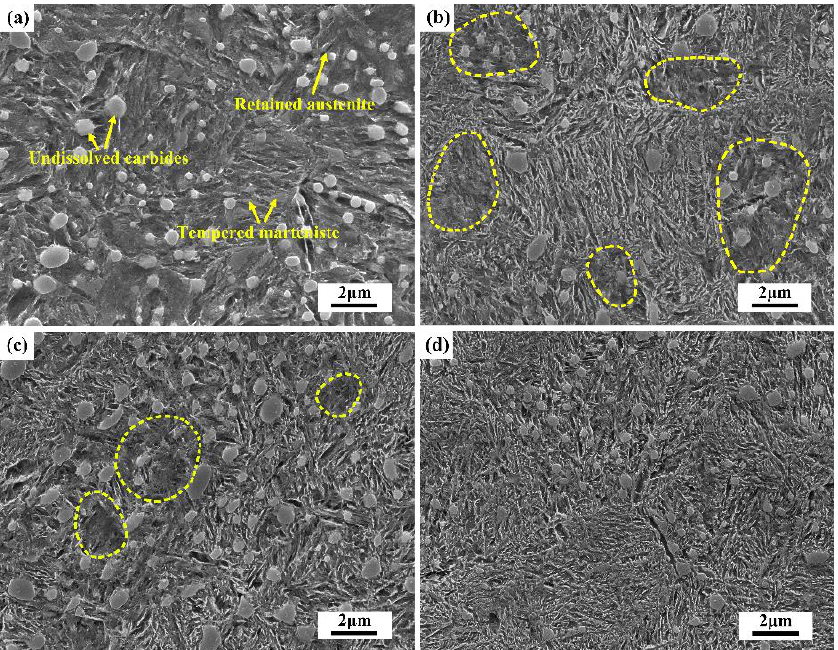
Figure 6. Typical field-emission scanning electron microscope (FESEM) microstructure of the ( a ) quenching and tempering (QT) treated specimens, and the QT treated specimens after heating to 300 °C under tensile stress of ( b ) 0 MPa, ( c ) 20 MPa and ( d ) 40 MPa.